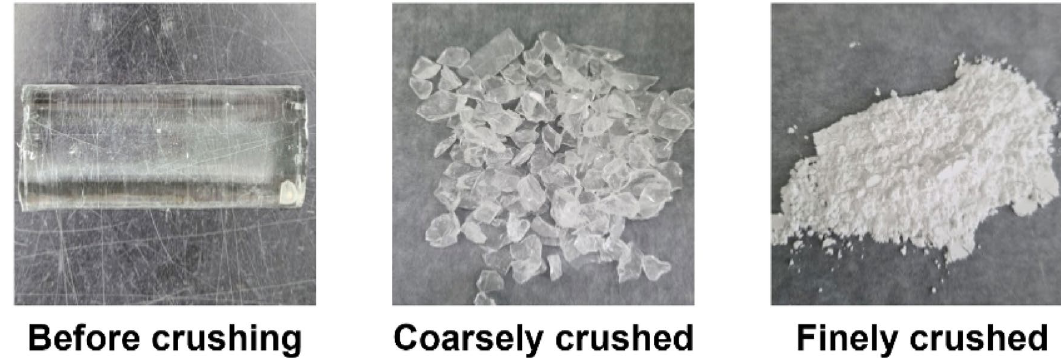
Figure 2. Photographs of glass for each step.